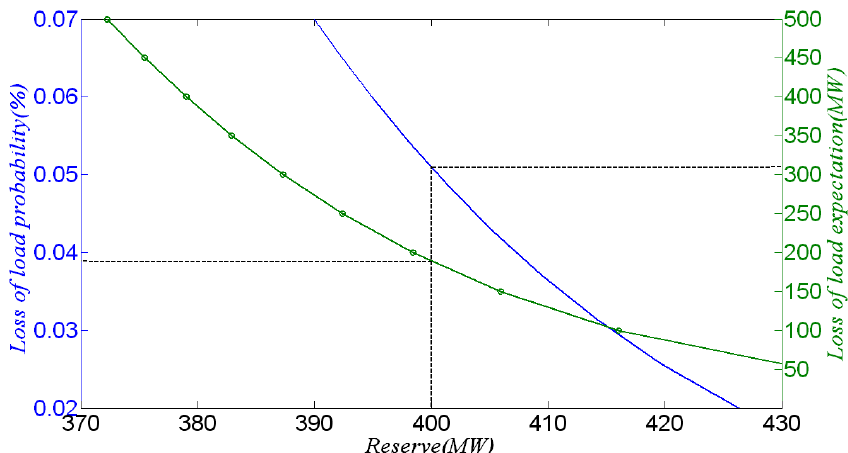
Figure 5. Relationship between reserve and loss of load probability and